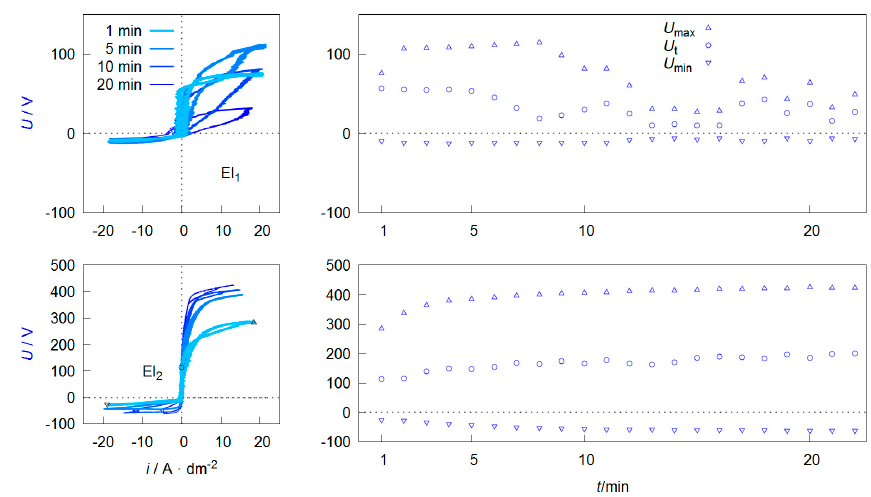
Figure 9. Voltage current curves of VCC (left) and course of maximum U max , threshold U t and minimum U min voltage during the process (right) of the PEO experiments described in Figure 8.